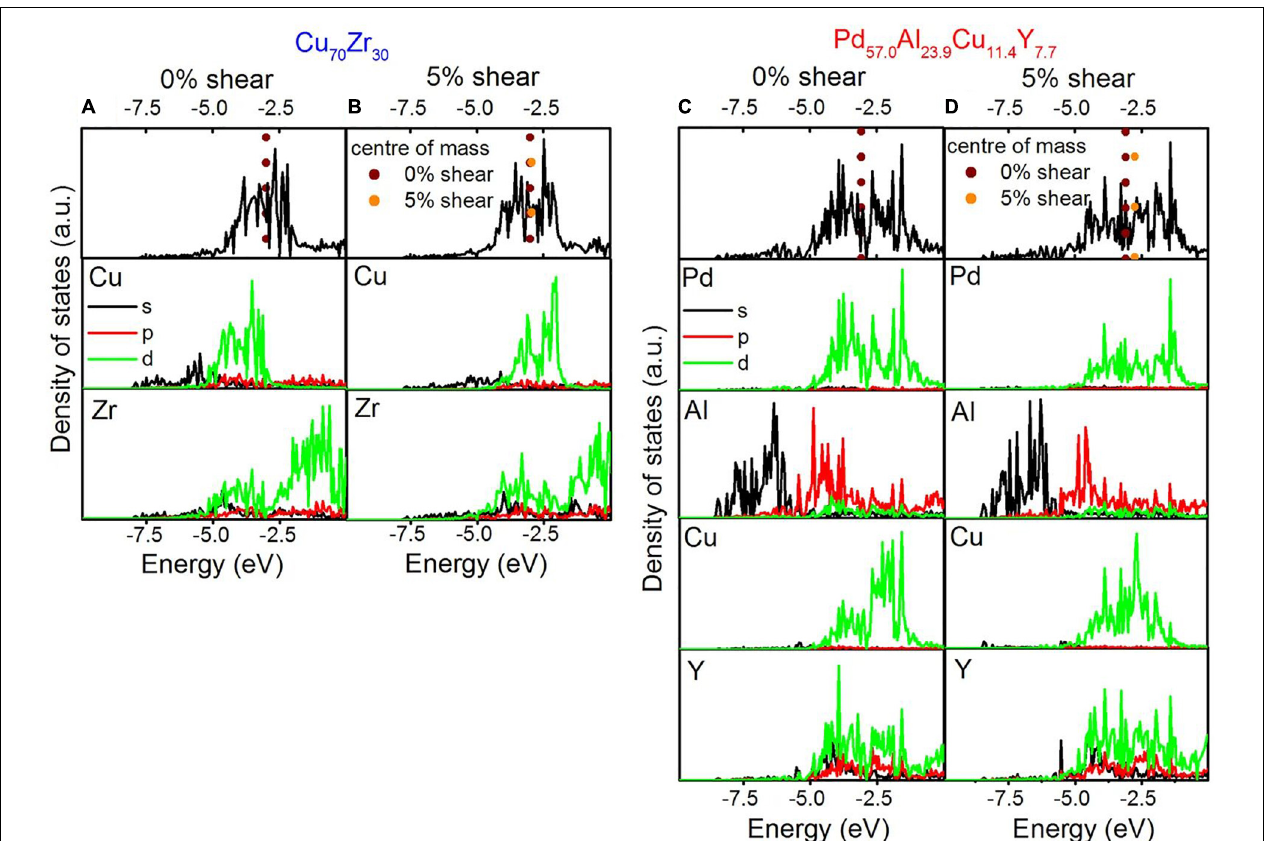
FIGURE 4 | Electronic density of states of Cu 70 Zr 30 (A,B) and Pd 57 . 0 Al 23 . 9 Cu 11 . 4 Y 7 . 7 (C,D) . The density of states for the simulation cells without shear is shown in (A,C) and with 5% shear in (B,D) . The Fermi level is set to 0 eV. Reproduced from Schnabel et al. (2016a) under the Creative Commons CC BY license.